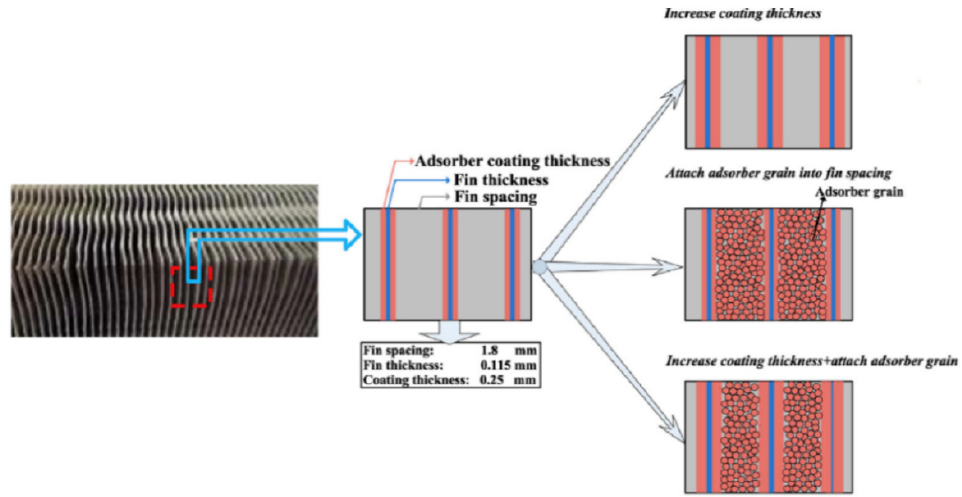
Figure 11. Adding more adsorbent into the fin spacing of coated Ad-HEx. Reprinted/adapted with permission from Ref. [118]. (Copyright 2013), Elsevier.